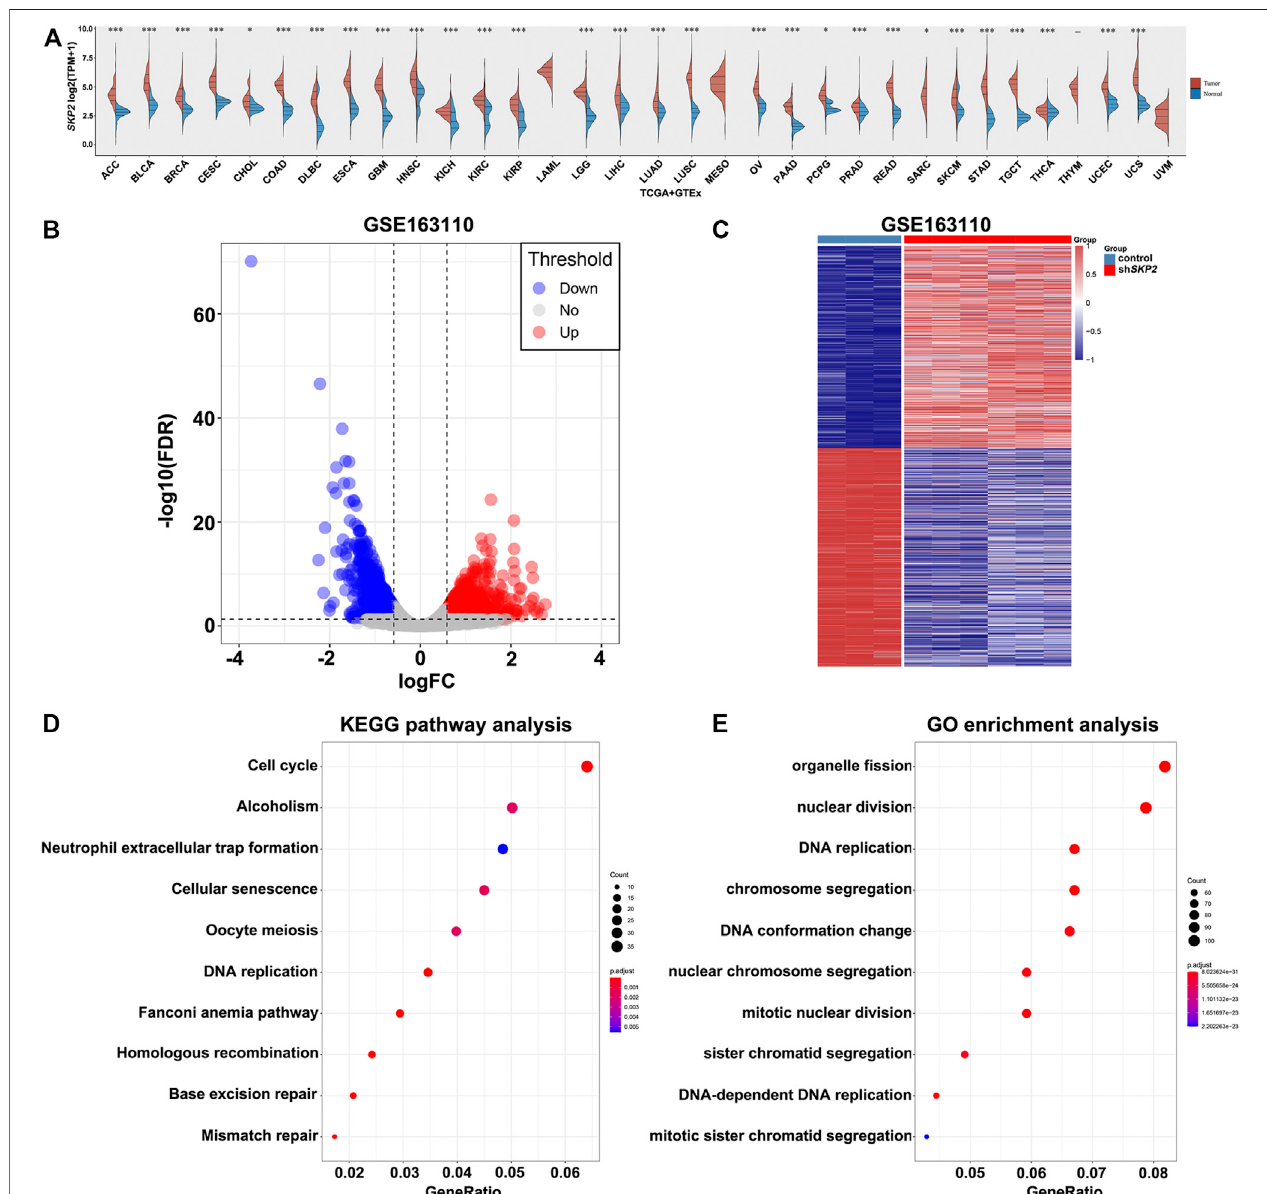
FIGURE 7 | The expression analysis of SKP2 in pan-cancer and its functional analysis. (A) The expression level of SKP2 in different cancer types from TCGA and GTEx data. (B) Volcano map for DEGs between control and sh SKP2 group with p value < 0.05, | Fold Change | > 1.5 as the cut-off criteria. (C) Heat map for hierarchical clustering of DEGs. (D) The top 10 KEGG pathways of DEGs. (E) The signi fi cant-top 10 GO functional